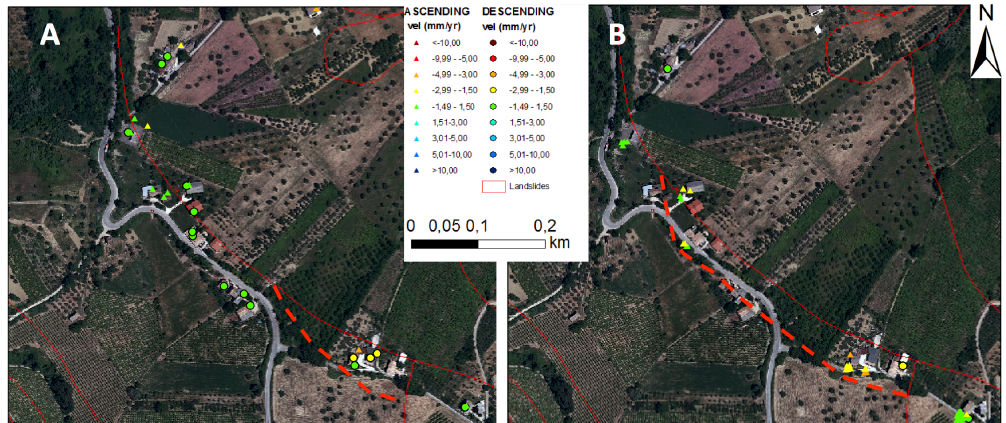
Figure 8. Example of crown retrogression for a large slide in the northwestern part of the study area: ( A ) ERS (ascending and descending) results (1992–2001); and ( B ) Envisat (ascending and descending) results (2003–2010). The example shows progressive evolution of the expansion phenomenon over time. The red dashed line represents the gradual retrogression.